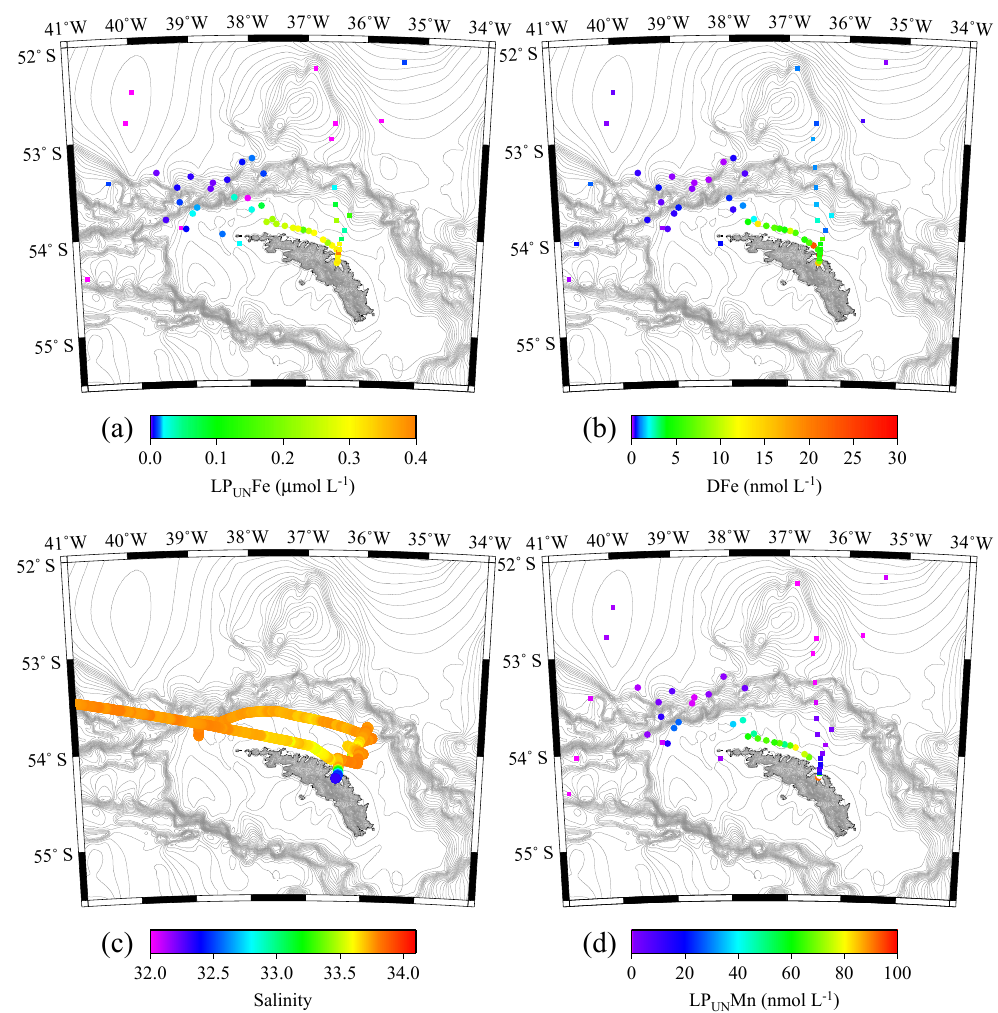
Figure 6. Tow fish seawater samples: concentrations of leachable particulate Fe (LP Un Fe) of unfiltered seawater samples (a) , dissolved Fe (DFe) (b) , salinity (c) , and leachable particulate Mn (LP Un Mn) in unfiltered seawater samples (d) in surface waters collected during JR247 (circles) and JR274 (squares) around South Georgia. The highest LP Un Fe concentration was recorded in a single sample in Cumberland Bay, reaching 2.2µmolL − 1 . Because of generally lower concentrations, we excluded this data point in panel (a) . Isobath are represented by grey lines (GEBCO gridded bathymetry